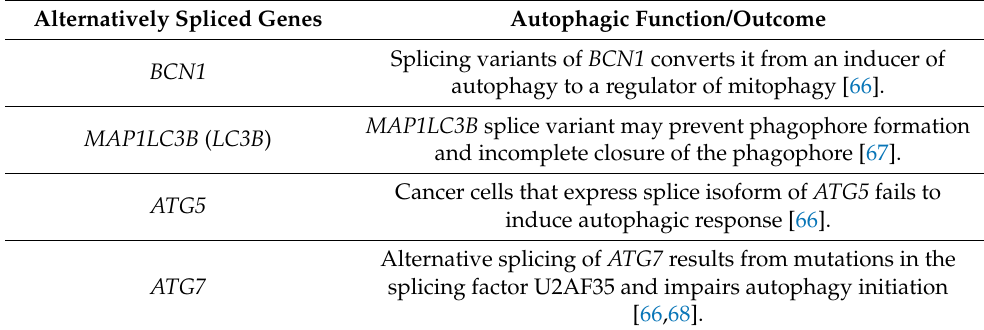
Table 2. A summary of autophagy genes that are subject to alternative pre-mRNA splicing with consequences for